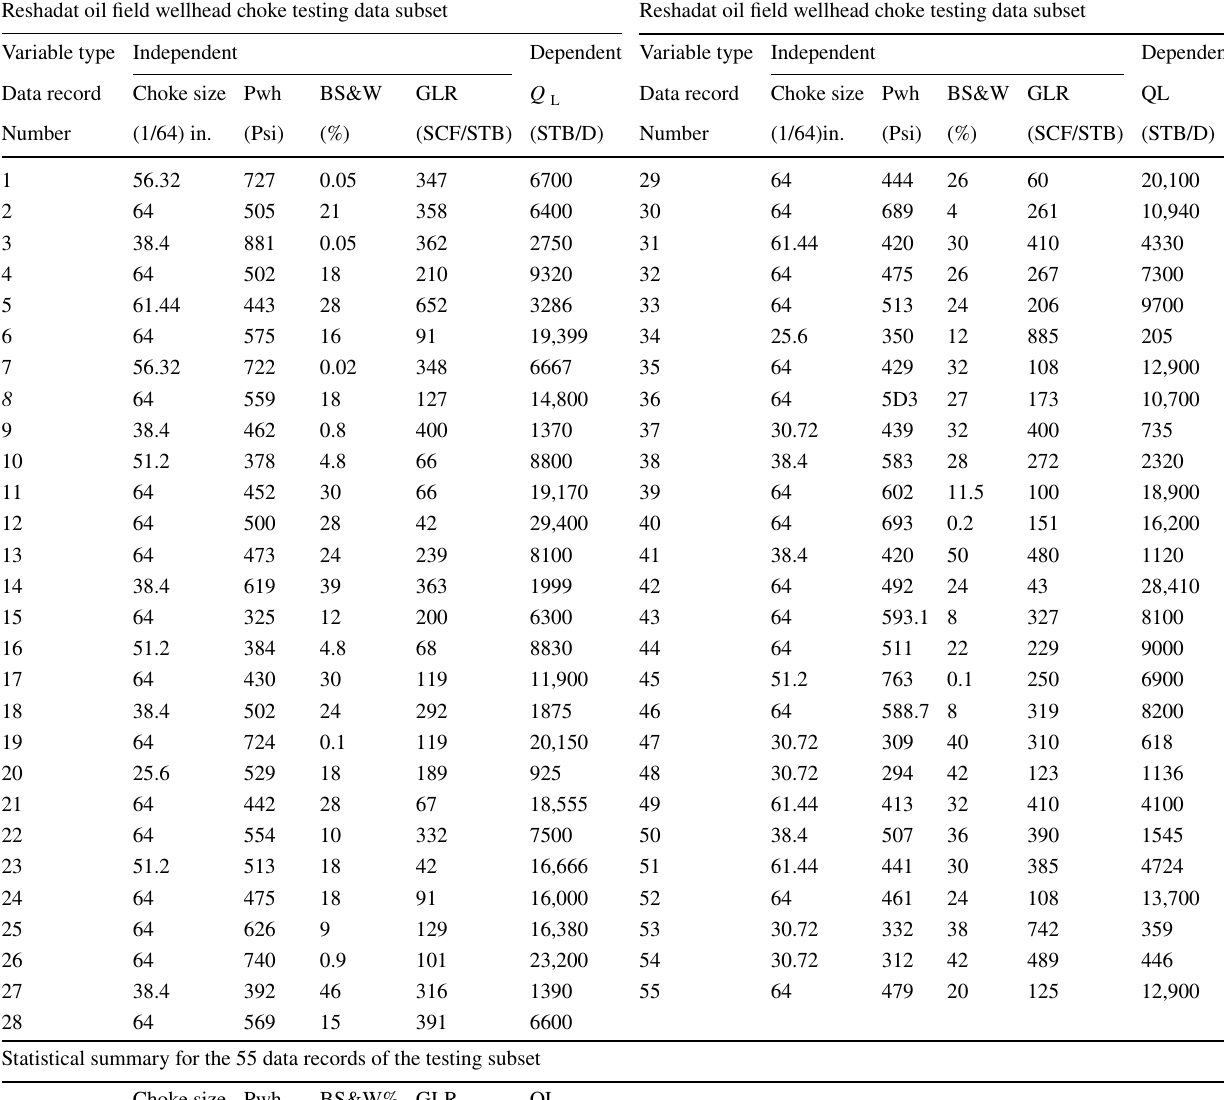
Table 6 Reshadat oil field wellhead test data—accuracy testing subset (55 records—30% of database) Reshadat oil field wellhead choke testing data